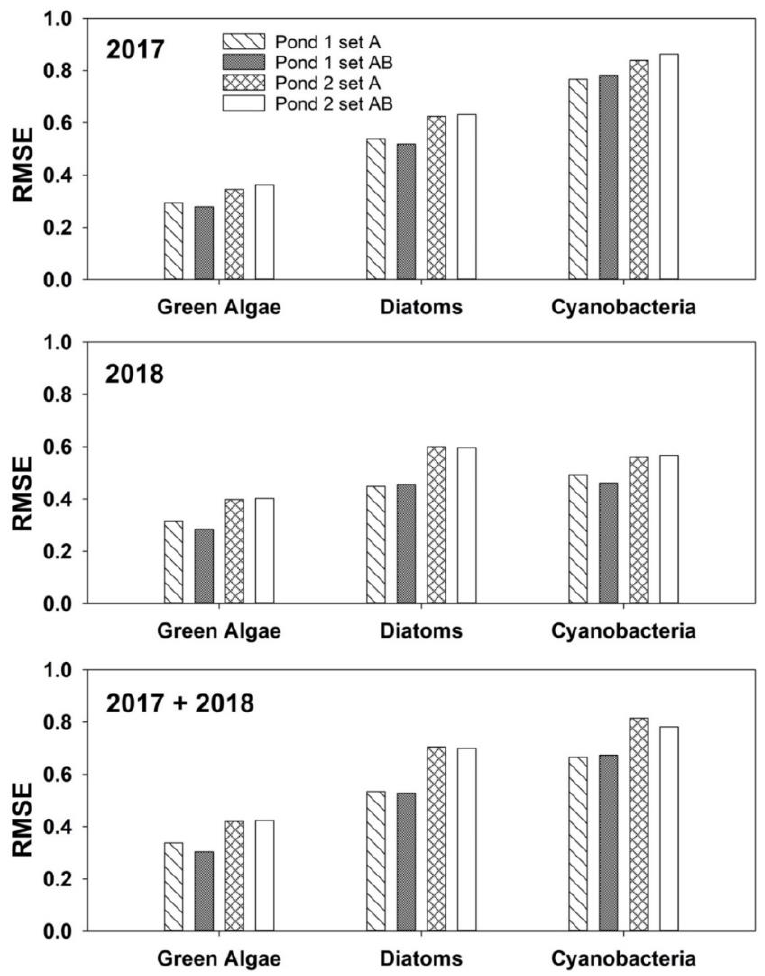
Figure 2. Root-mean-squared errors (RMSEs) of the random forest models for green algae, diatoms, and cyanobacteria for Ponds 1 and 2, with data from 2017, 2018, and 2017 + 2018. Table 2. Random forest accuracy RMSE for cyanobacteria